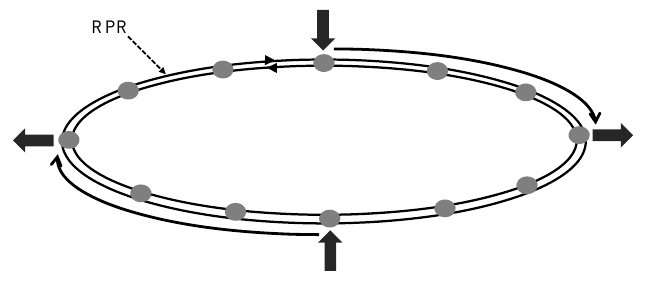
Figure 1. Destination stripping and spatial reuse in